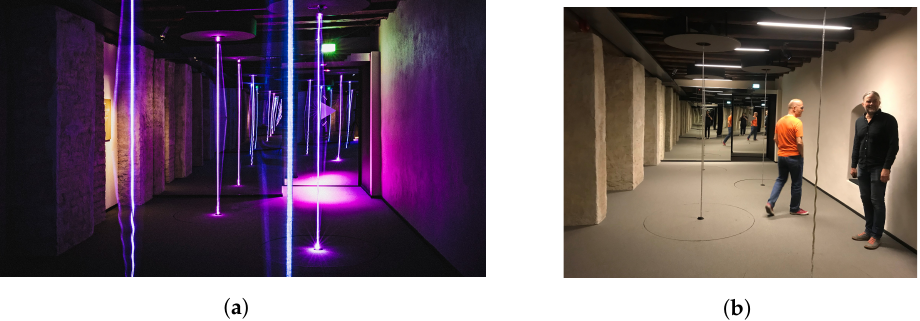
Figure 1. ( a ). The Sound Forest installation. ( b ). The Sound Forest installation when not active, showing strings and haptic platforms providing whole-body